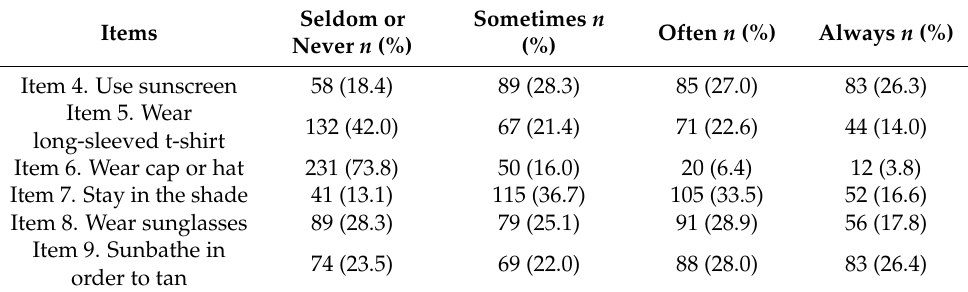
Table 2. Sun protection practices and tanning preferences.